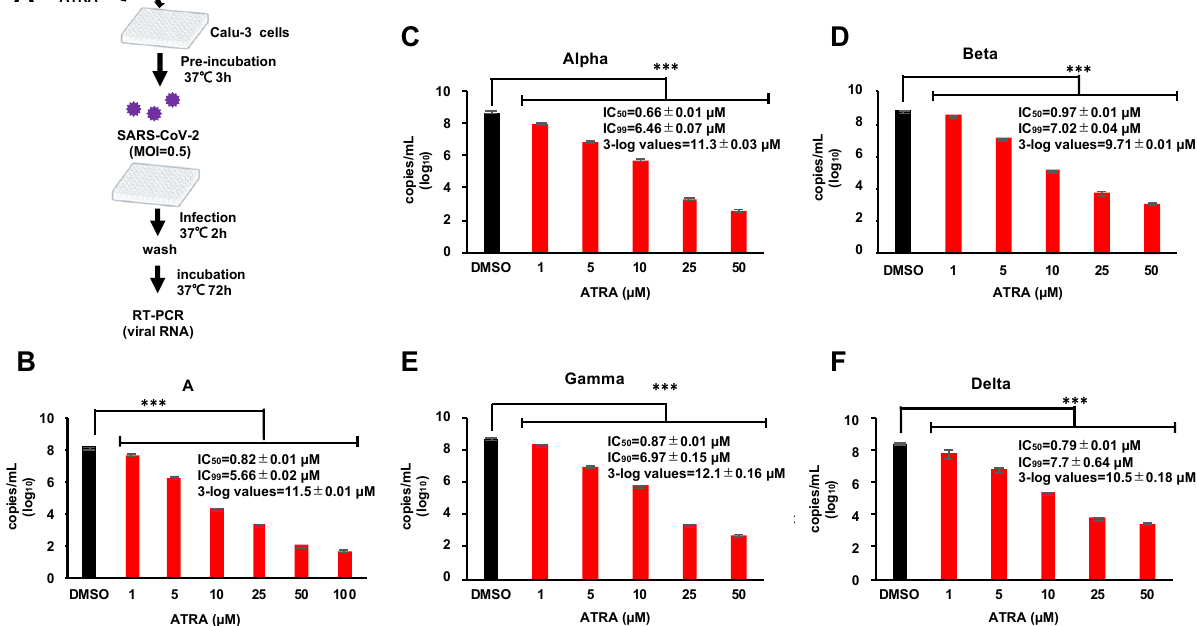
Figure 4. ATRA is effective against the SARS-CoV-2 variants of concern in the human lung cell line ( A ) Calu-3 cells, pre-incubated with ATRA at 37 °C for 3 h, were infected with SARS-CoV-2; A, alpha, beta and gamma (MOI = 0.5) for 2 h. Following this, the non-adsorbed virus was washed, and the infected cells were incubated in a fresh medium containing ATRA for 72 h. ( B – F ) Inhibition of different VOC by ATRA. The results of RT-PCR for lineage A ( B ), alpha strain ( C ), beta strain ( D ), gamma strain ( E ), and delta strain ( F ). Error bars obtained from duplicate testing. p -value < 0.005 (***).